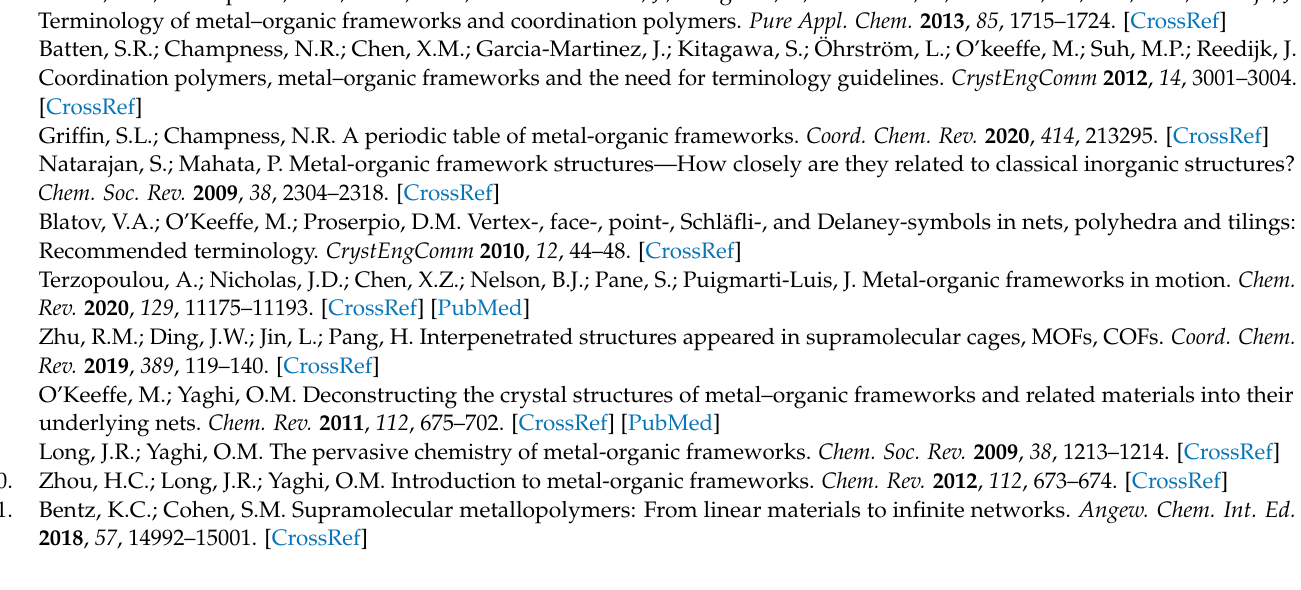
Table S4: Anisotropic displacement parameters (Å 2 × 10 3 ), Table S5: Hydrogen coordinates ( × 10 4 ) and isotropic displacement parameters (Å 2 × 10 3